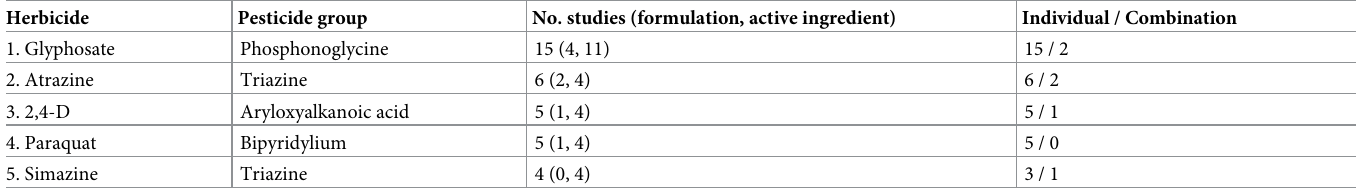
Table 3. The most studied herbicides ranked in descending order, and whether they were studied individually or in combination with other PPPs. The number of studies that used a formulation or the analytical grade active ingredient alone, are displayed in parenthesis. Herbicide